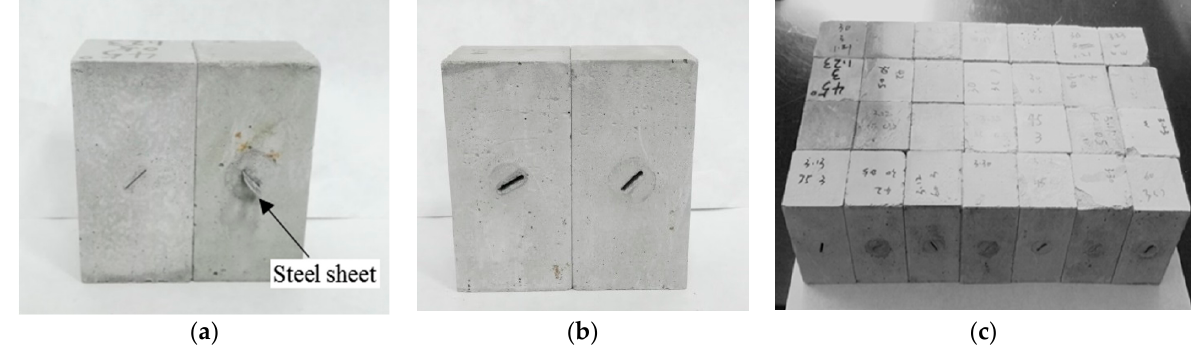
Figure 1. Concrete specimen with a single fracture. ( a ) Test sample with 0.5 mm width single crack (left), and the 0.5 mm thick steel sheet is inserted into the cracks to fill the cracks; ( b ) Test sample with 3.0 mm width single hollow crack; ( c ) samples with different crack angles.